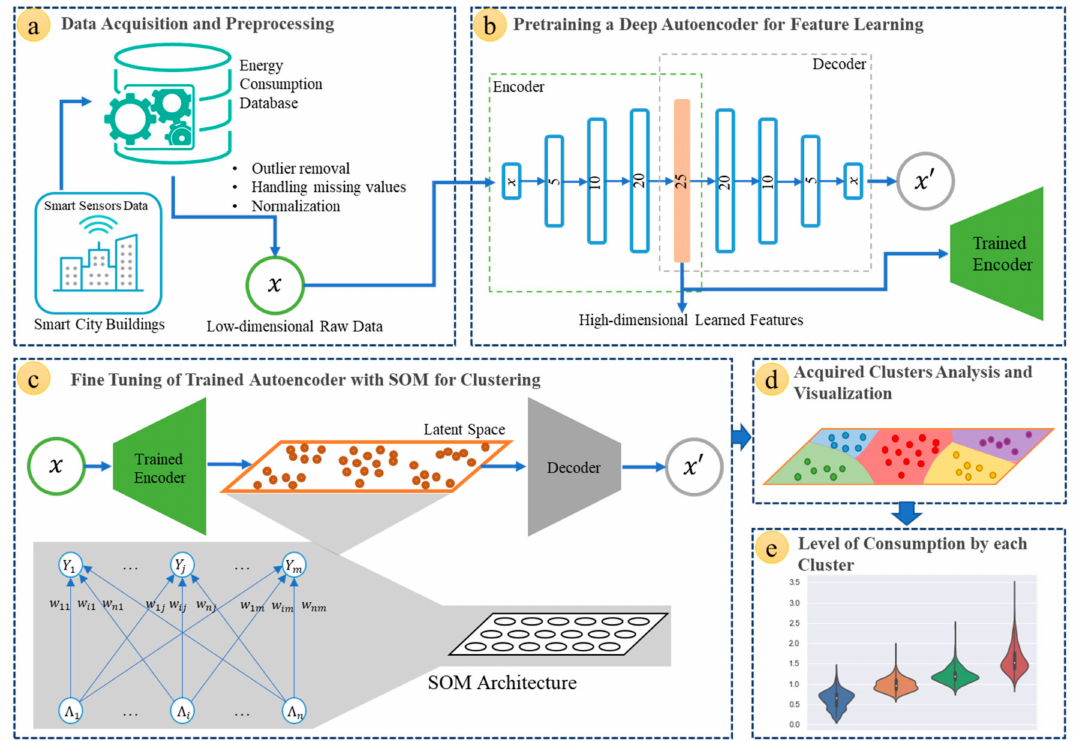
Figure 1. Framework of the proposed building energy consumption level prediction: ( a ) Data are obtained from the buildings’ smart sensing devices and preprocessed for removing outliers and normalization, ( b ) a deep autoencoder is pre-trained to convert low dimensional sensors data into higher-level representations, ( c ) the pre-trained autoencoder is trained along with the SOM clustering layer, ( d ) visualization of the obtained clusters, ( e ) finding the energy consumption level of each cluster